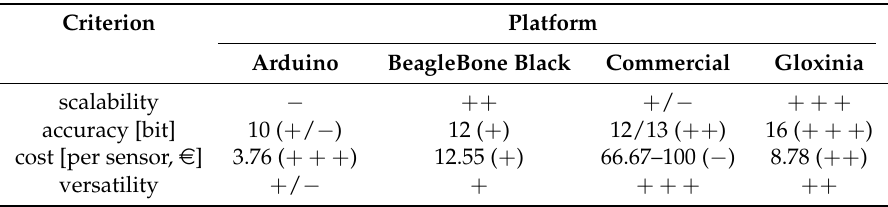
Table 5. Detailed comparison and summary of the evaluation of the different sensor platforms. The cost values are based on the cost per sensor for the small first experiment. The following scores are given from lowest to highest for a particular metric: − , + / − , + , ++ , and + + + .